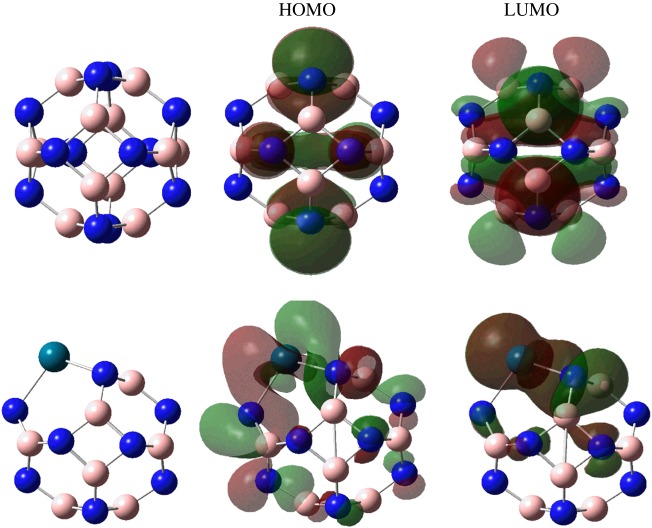
The optimized structures of undoped B12N12 cluster and Pd-doped B11N12Pd SAC and the corresponding calculated HOMO and LUMO at B3LYP/6-31++G** level. H, white; B, pink; N, blue; Pd, blue-green.